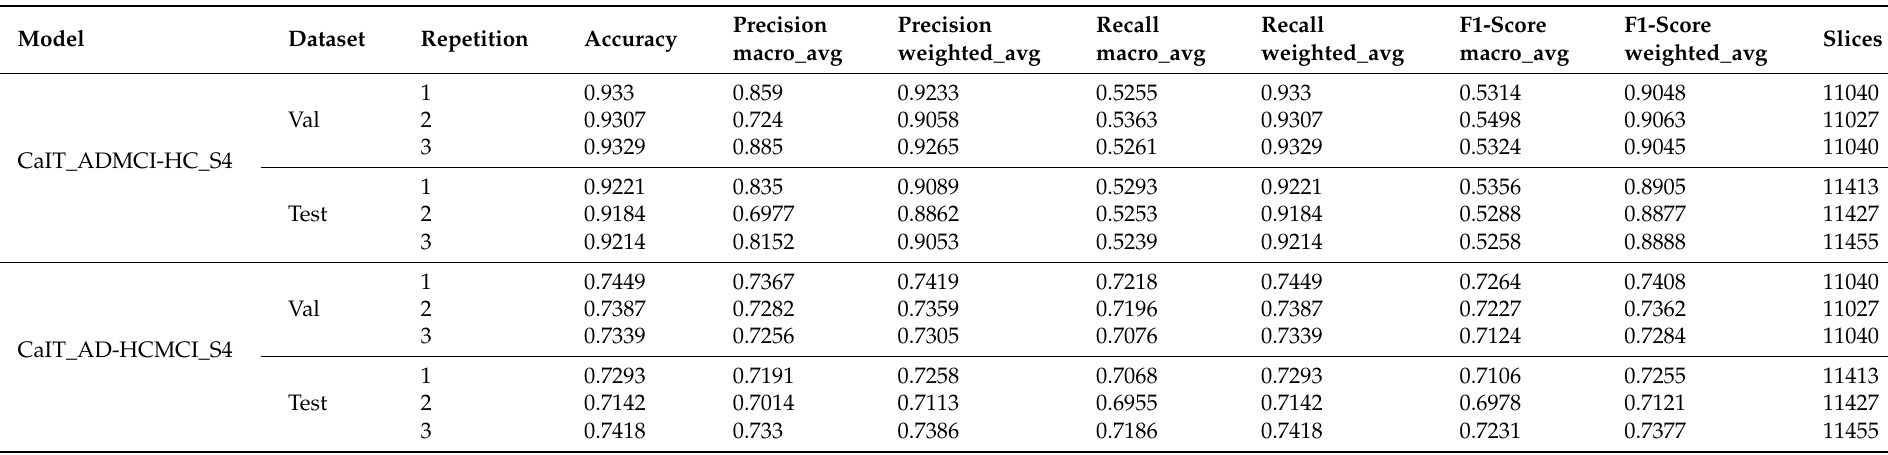
Table A4. The slice-level performance of structural MRI models using the preprocessed data with spatial smoothing sigma = 4 mm (S4). The naming convention for models and classes is as in the previous tables.